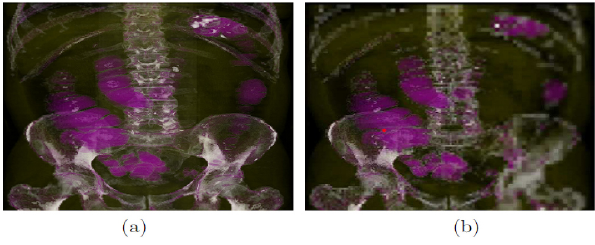
Fig. 7 Fast rendering of foveated volumes in wavelet-based representation proposed by Yu et al. [107]. (a) is rendered with a full resolution, (b) is rendered with this method, and the fovea is situated at the red dot. This method achieved a 1.3–8 × improvement in speed compared with the full resolution ray casting. Reproduced with permission from Ref. [107], c (cid:13) Springer-Verlag